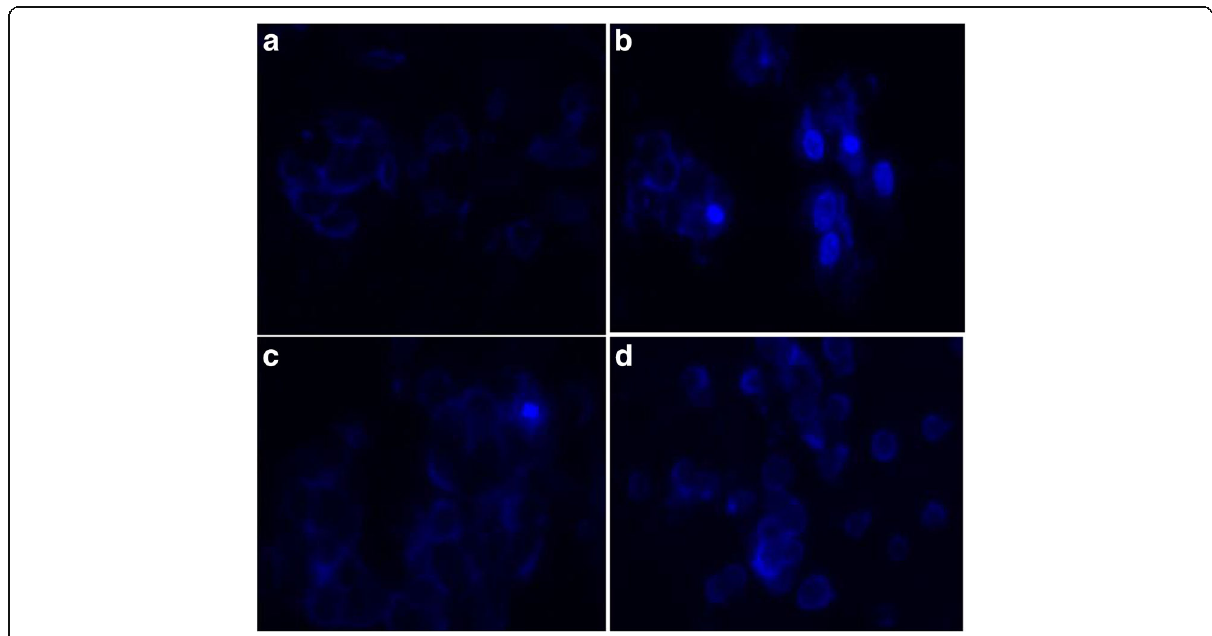
Fig. 7 Nuclear morphology of SH-SY5Y cells stained with DAPI. Neuronal cells stained with DAPI showing the antiapoptotic effect of DMC (50 nM) against rotenone (100 nM). Nuclear condensation and/or fragmentation are indicator of apoptosis. a Control, b rotenone, c DMC + rotenone and d DMC. It is possible to observe some apoptotic cells in B, but not in the others